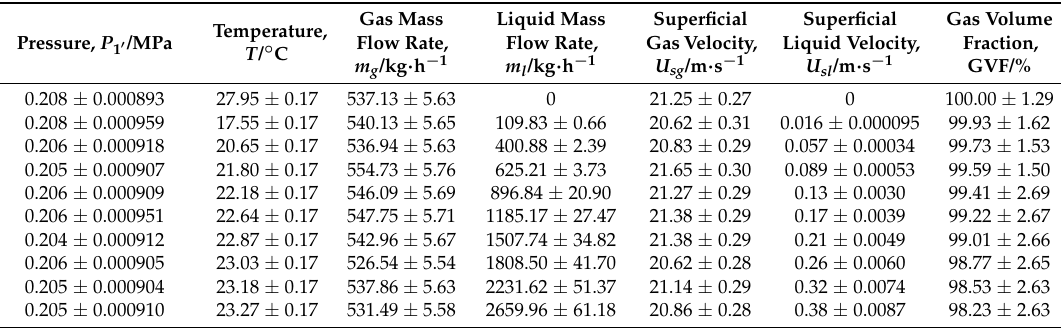
Table 3. Test conditions and uncertainties of the measurement